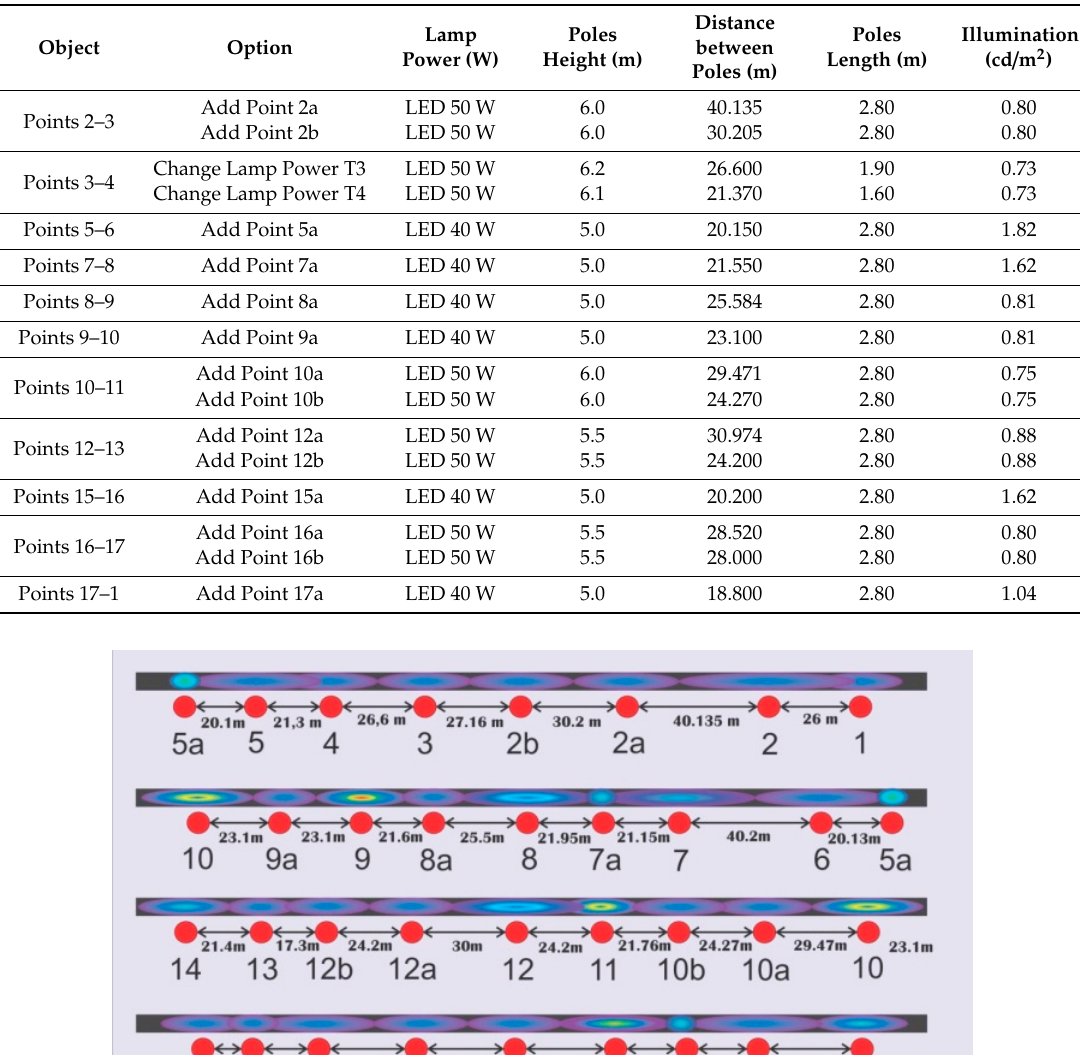
Table 3. Simulation results of Alternative 2.